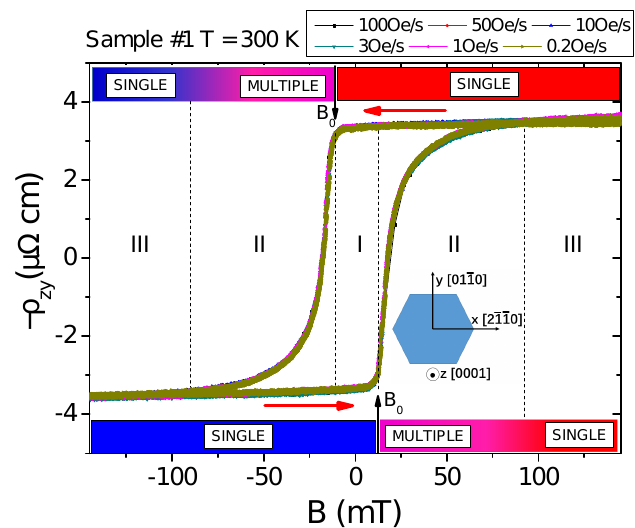
Sn: − ρ A Figure 1: Hysteretic anomalous Hall effect in Mn as a function of mag- 3 zy netic field in Mn Sn has a peculiar shape. Three different regimes can be identified. 3 When the field is lower than B , marked by a vertical arrow, the spins keep their 0 configuration despite the magnetic field (regime I). When B > B (regime II), do- 0 mains conform to the orientation of the field are induced. At sufficiently high fields, these new domains occupy the bulk of the sample, which becomes single-domain again (regime III). The hysteretic loop is reproducible even when the sweeping rate changes by a factor of